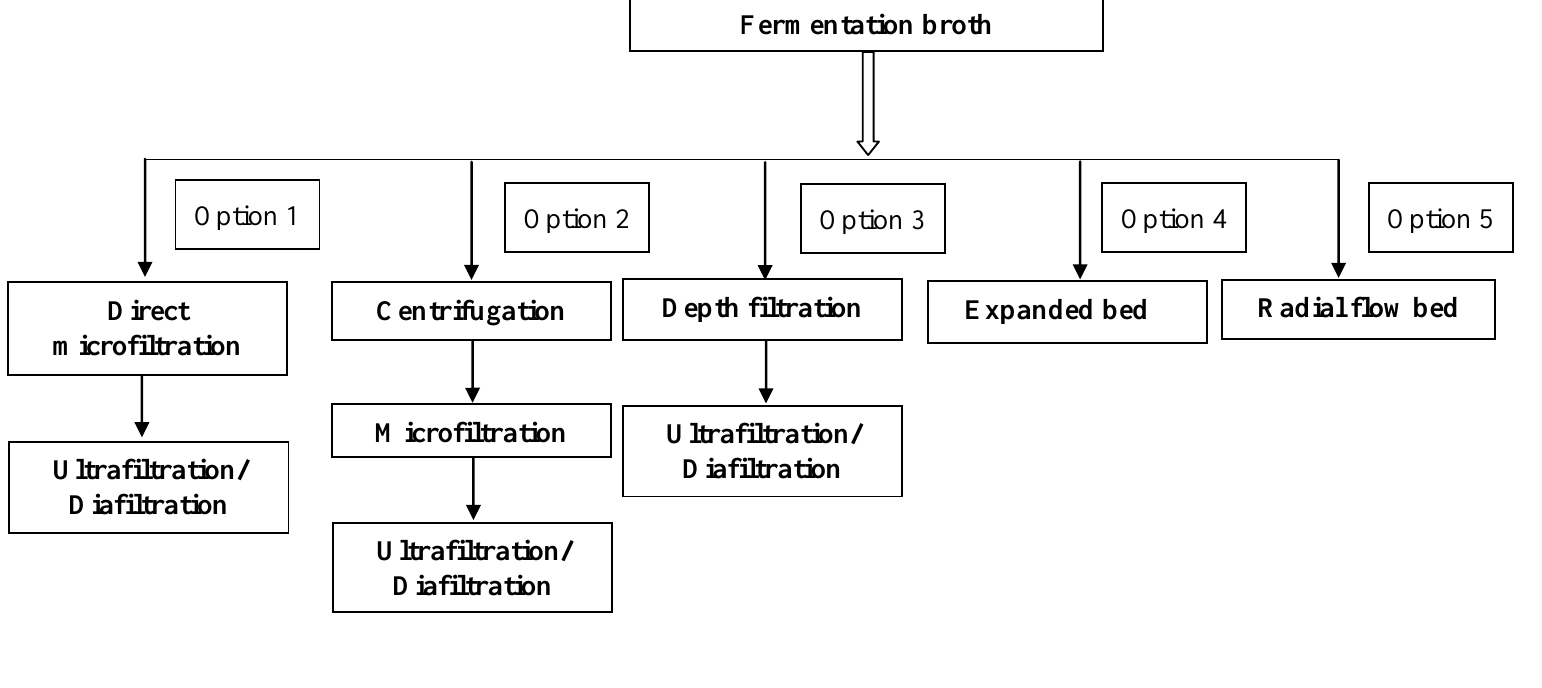
Figure 1. Different options for harvest of a therapeutic protein from Pichia pastoris